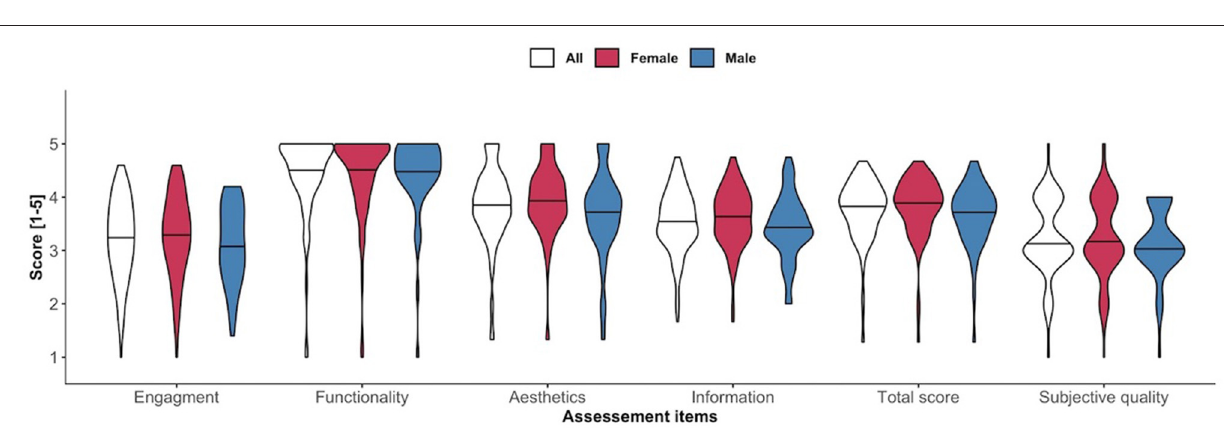
FIGURE 3 | Violin plots of uMARS subdomains, total score and subjective quality according to